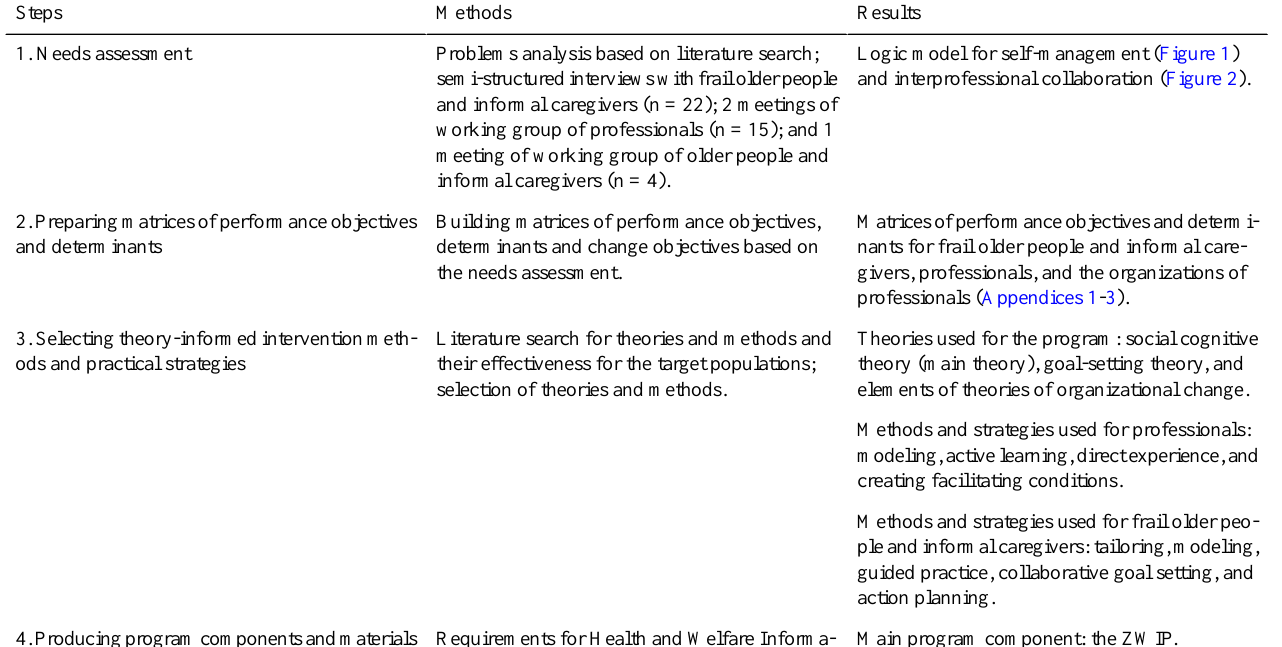
Table 1. Overview of the intervention mapping process.